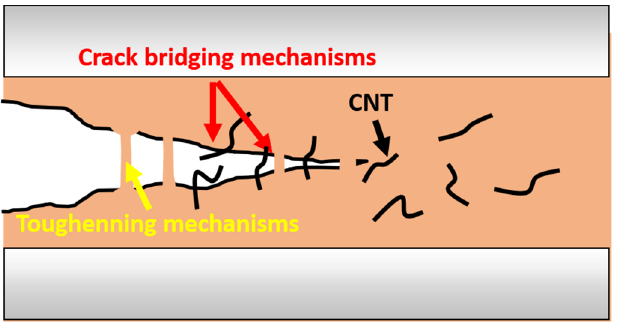
Figure 3. Schematics of crack-bridging mechanisms in CNT/PCL/epoxy multiscale composites. Phase-separated PCL/epoxy blends are obtained through phase separation and in- duced by chemical reaction. In this case, PCL is soluble into the mixture of monomers, but it becomes immiscible as the epoxy molecular weight increases during the curing reaction process. Phase separation involves several processes while it cures: onset of phase separa- tion, gelation, growth and fixation of the phase separated size, end of phase separation, and vitrification. Phase separation can be inhibited when the blend is at high viscosity, gelation, or vitrification.